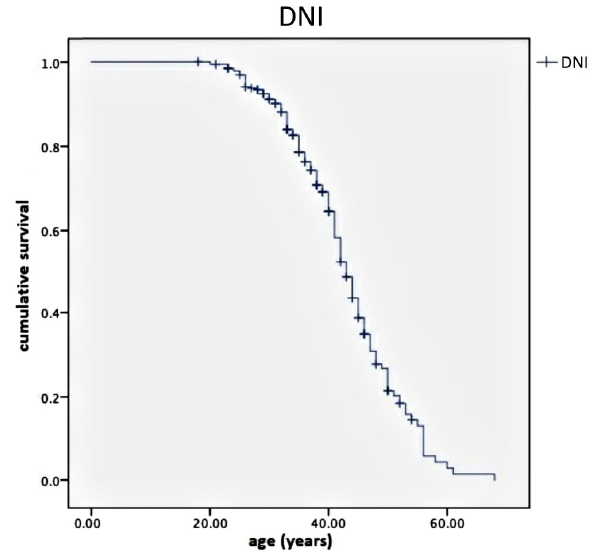
Figure 6. Kaplan–Meier curves showing DNI according to the considered age range. Note the increasing slope curve near the age value of 39 to 40 years. This is the cut-off value indicating the rapid annulment of the disability differences between the patients belonging to the NTZ group and those of the DMF group. DNI is expressed by the ratio between the EDSS of patients treated with NTZ and the EDSS of patients treated with DMF, matched for age, disease duration and age at onset of disease. DNI—Differential Neurological Impairment; EDSS—Expanded Disability Status Scale; NTZ—Natalizumab; DMF—Dimethyl fumarate.